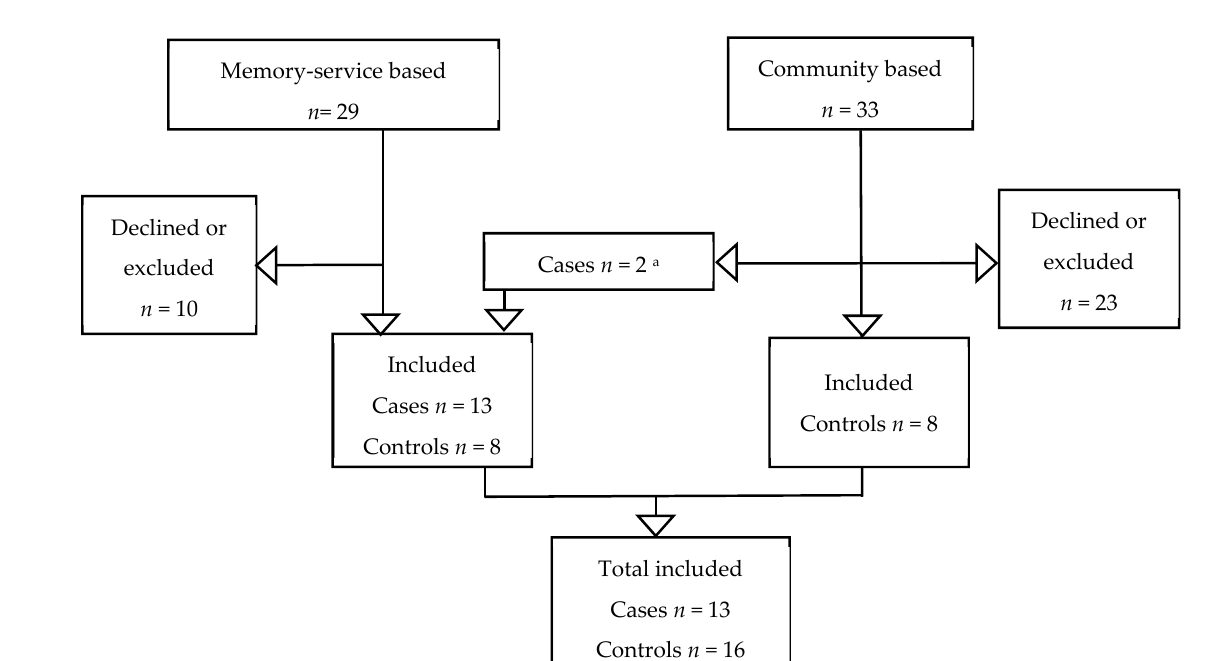
Figure 1. Recruitment flow-chart. a Two cases were identified in the community-based feasibility study: both were identified patients who had previously attended the memory service and therefore met the eligibility criteria for memory service-based cases.